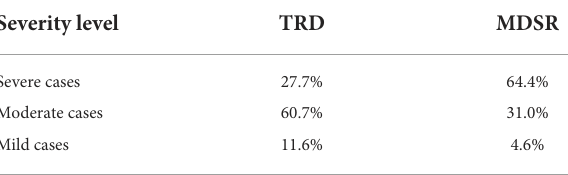
TABLE 1 Distribution of estimated TRD and MDSR cases by the level of